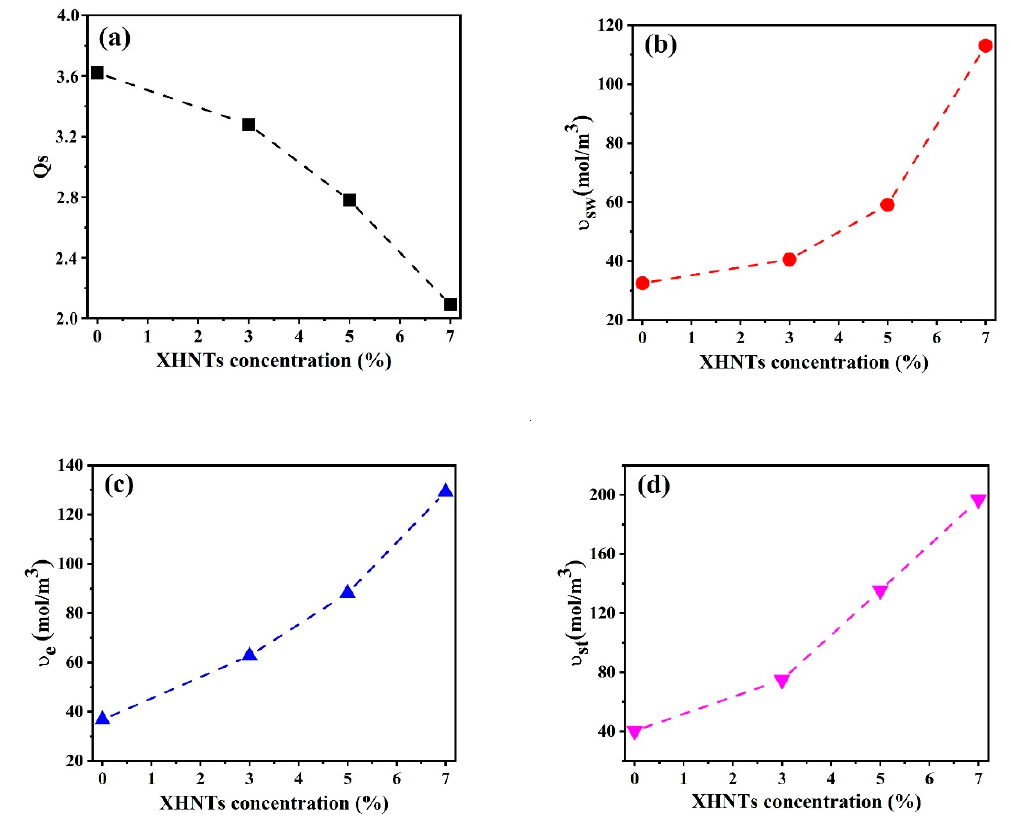
Figure 9. Swelling behavior of XNBR / epoxy nanocomposites containing various XHNTs concentrations ( a ) swelling ratio, ( b ) cross-link density resulted from swelling analysis, ( c ) cross-link density resulted from stress–strain measurements, ( d ) cross-link density resulted from dynamic mechanical thermal analysis (DMTA).